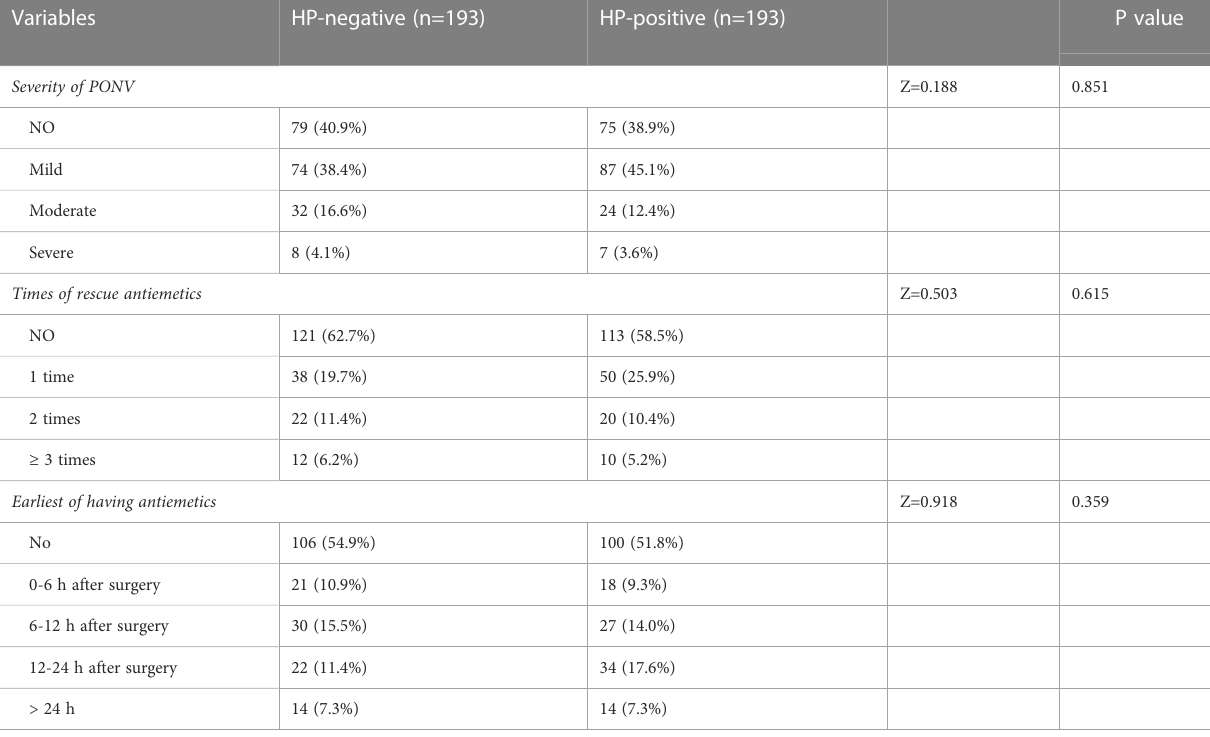
TABLE 3 Occurrence and severity of PONV and the Use of rescue antiemetics (n=193).